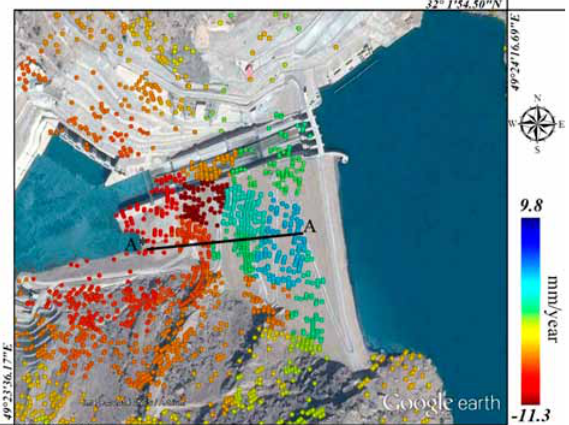
Fig. 5. Velocity map on Google Earth